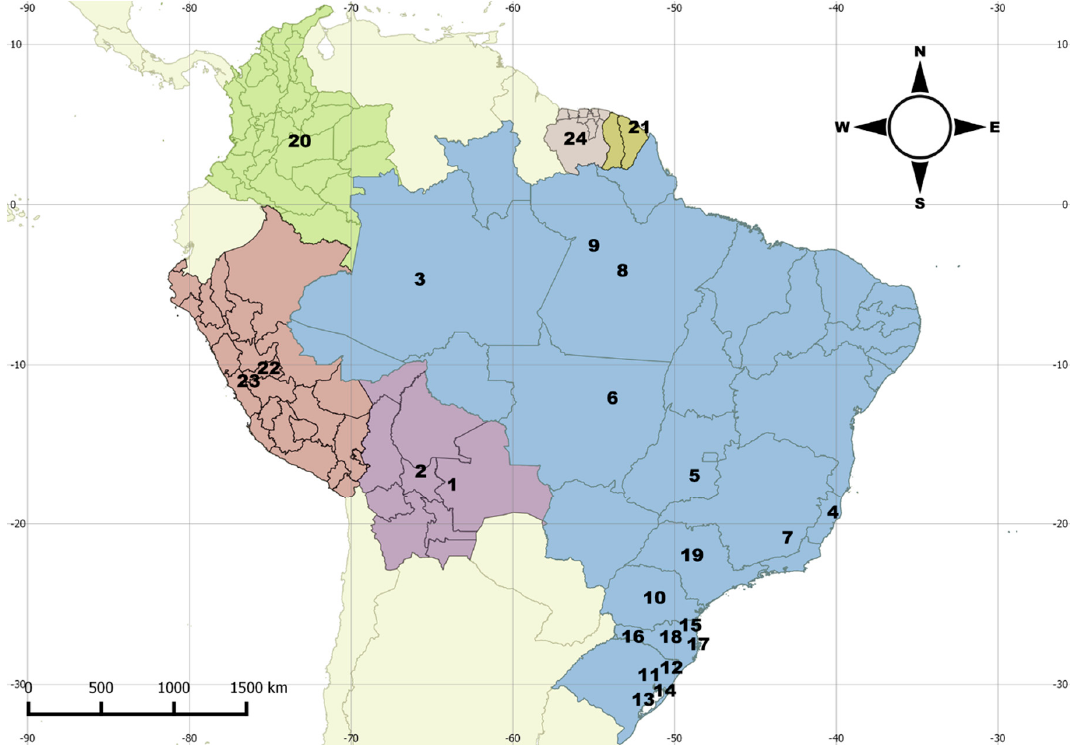
Figure 3. Distribution map for Mycotretus tigrinus (Olivier, 1792). Bolivia (1–2): 1—Buena Vista,